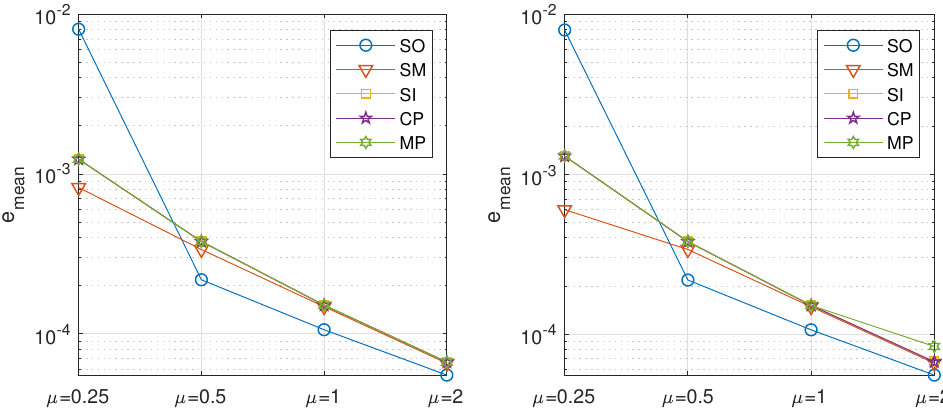
Figure 8. Mixed convection-diffusion and Burgers’ equation, directional decomposition. Precision of the proposed methods: sequential iterative SI, classical parallel CP, and modern parallel MP, compared with the classical ones: sequential operator SO and Strang–Marchuk SM, for different viscosities µ . Left: order 2 approximation and right: order 4 approximation for the discretization of the spatial